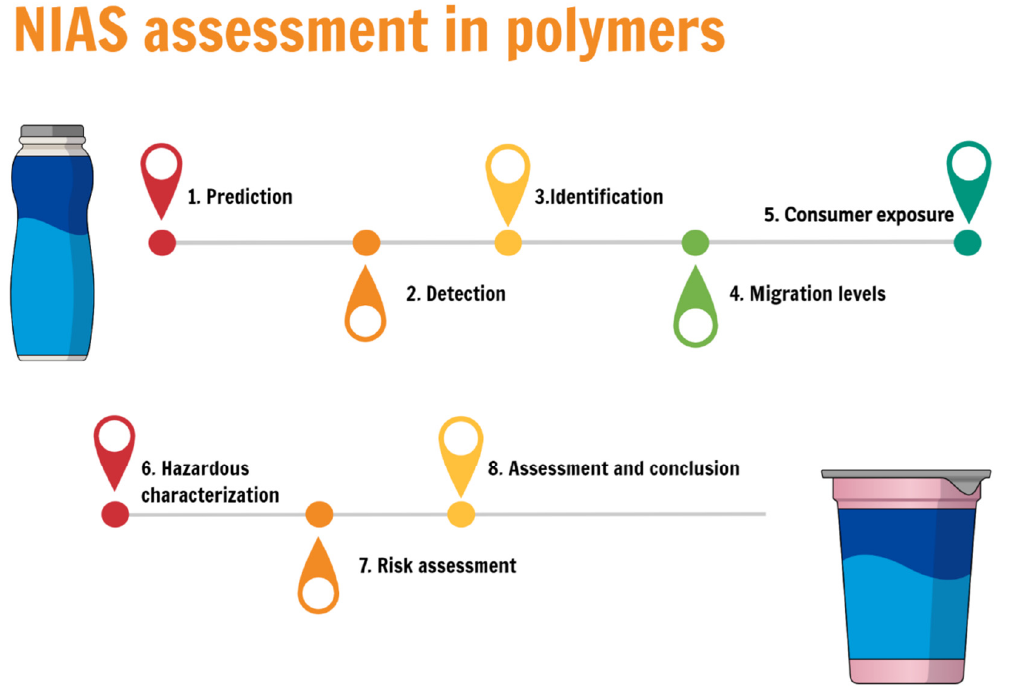
Figure 5. Steps involved in the NIAS assessment in